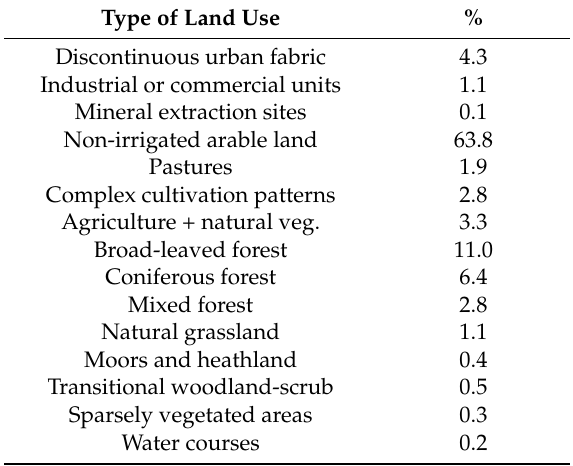
Figure 3. Land use in the Bacchiglione basin. Table 1. Classes of land use in the Bacchiglione basin according to Corine Land Cover 2012.